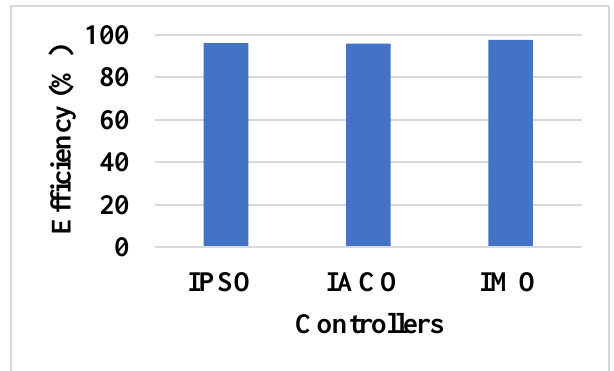
Figure 10. Performance of efficiency. Energies 2023 , 16 , x FOR PEER REVIEW Figure 10. Performance of efficiency. Figure 10. Performance of efficiency.